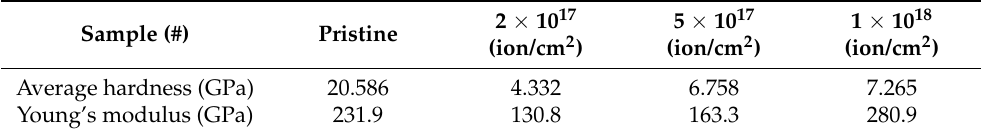
Figure 5. Depth-sensing indentation test results of different samples. Table 3. Hardness and Young’s modulus information.